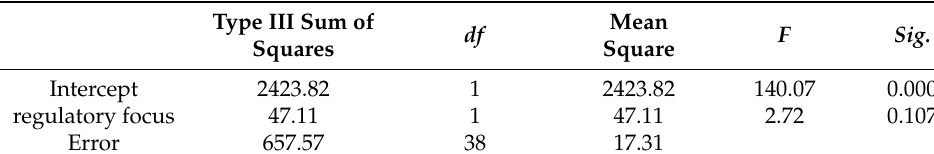
Table 5. Tests of Between ‐ Subjects Effects of N1 amplitude (regulatory focus).